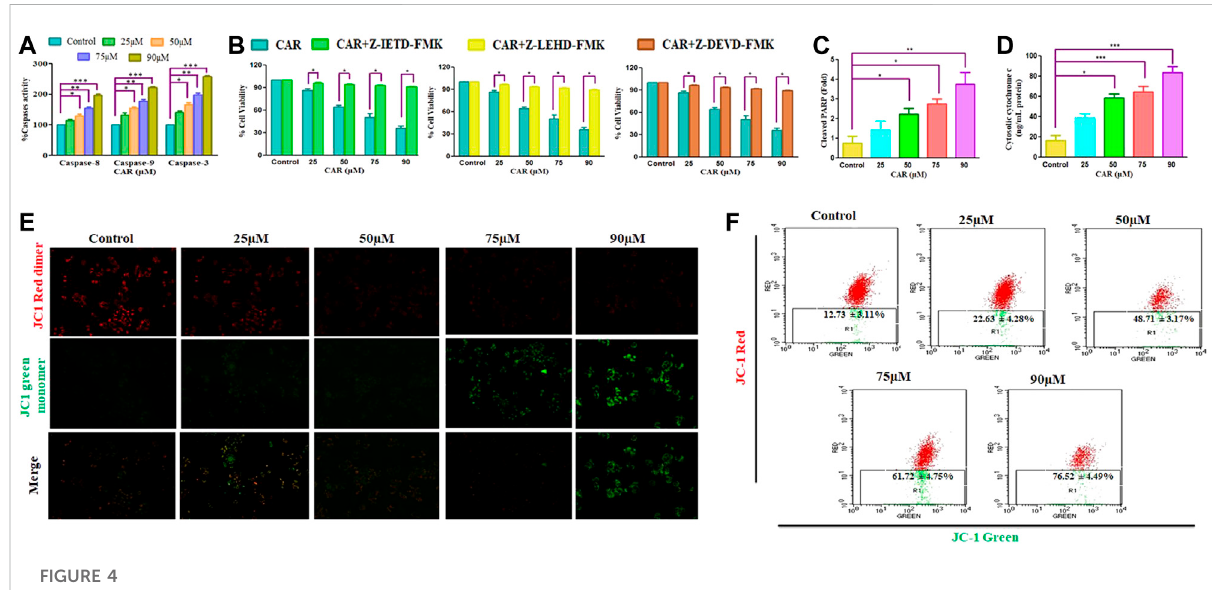
FIGURE 4 CARinducesapoptosisinC33A cellsthroughcaspaseactivation. (A) CARmediatesactivationofcaspase-8,-9and-3 (B) Percent(%)cellviability of C33AVcells pre-treated with a Z-DEVD-FMK (caspase-3 inhibitor), caspase-8 inhibitor (Z-IETD-FMK) and Z-LEHD-FMK (caspase-9 inhibitor) (C) CAR mediates PARP cleavage (D) release of cytochrome c in C33A cells (E) Fluorescent photomicrographs exhibiting dissipated MMP in